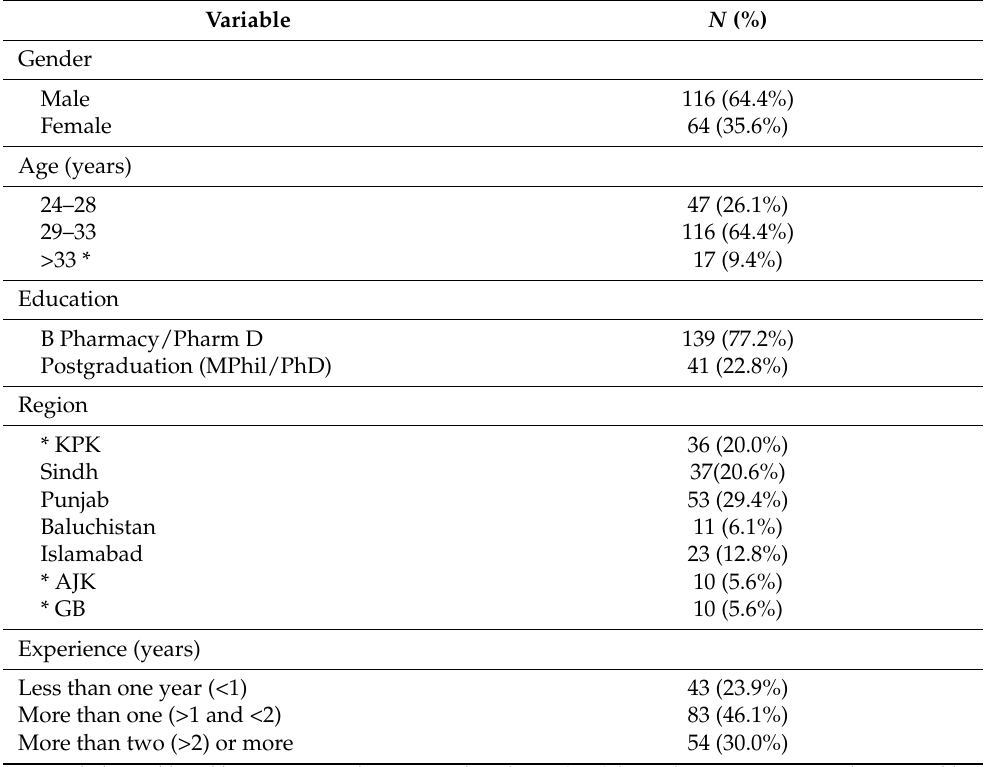
Table 1. Characteristics of respondents ( n = 180)